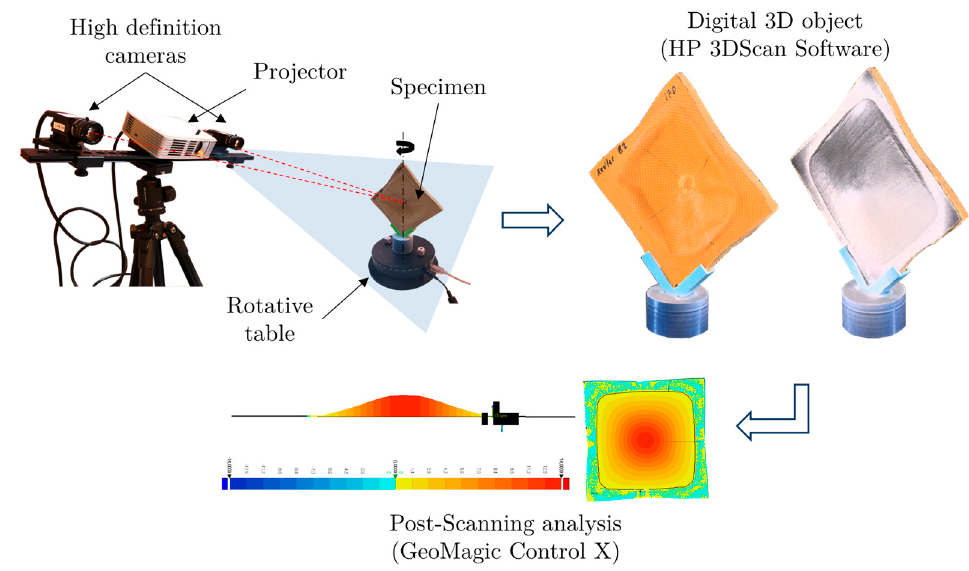
Figure 6. 3D scanner equipment to measure permanent deformation on samples.